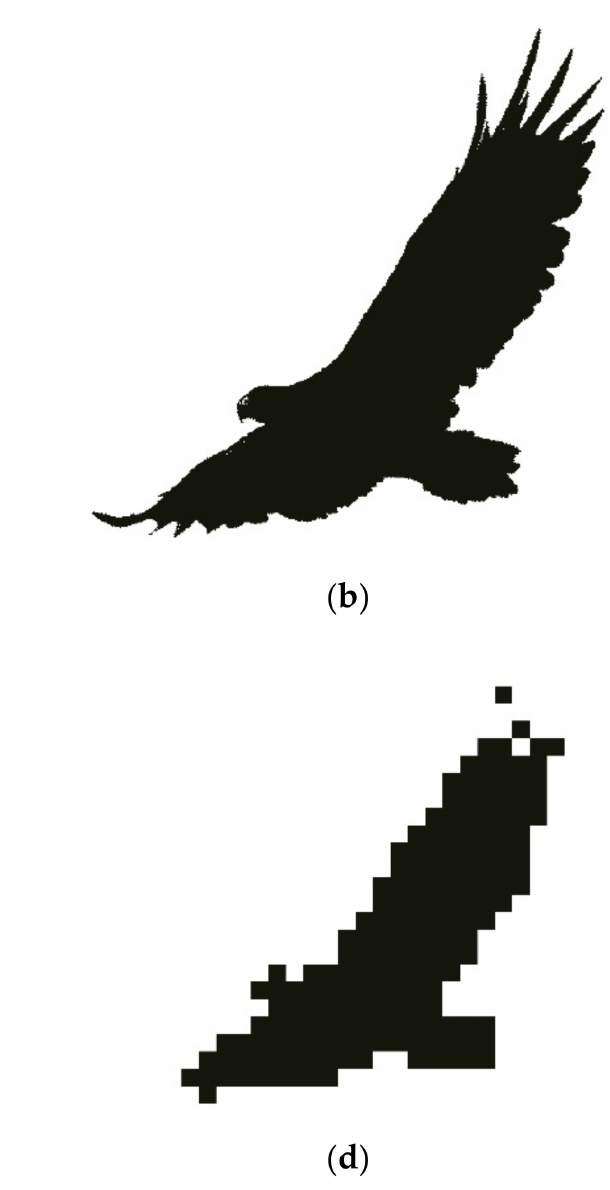
Figure 6. A pair of hypothetical mirrored eagle patterns at original resolution ( a , b ) and their resampled patterns at a 20 × coarser resolution ( c , d ). These hypothetical data sets were used to evaluate the method in terms of its sensitivity to changes in